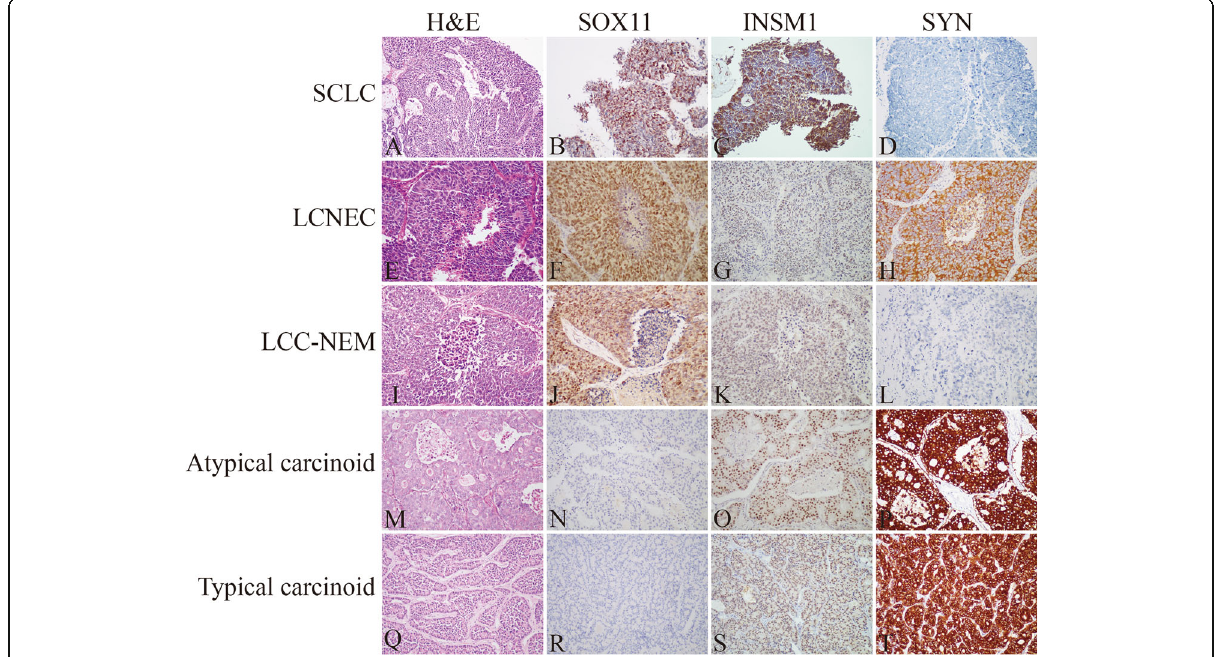
Fig. 1 Expression of SOX11, Insulinoma-associated protein 1(INSM1), and synaptophysin (SYN) in small cell lung carcinoma (SCLC), large cell neuroendocrine carcinoma (LCNEC), large cell carcinoma with neuroendocrine morphology (LCC-NEM), atypical carcinoid and typical carcinoid . A-D , SCLC. Small densely packed tumor cells exhibit a sheet-like diffuse growth pattern ( A ). Tumor cells demonstrate strong nuclear staining of SOX11 and INSM1( B, C ), negative staining of SYN ( D ) and other traditional neuroendocrine markers. E-H , LCNEC. Rosette-like structures and large zones of necrosis are observed in a LCNEC ( G ). Positive immunohistochemical staining was observed for SOX11, INSM1 and SYN ( F, G, H ). I-L , LCC-NEM. Large cell carcinoma demonstrating an organoid growth pattern ( I ). Tumor cells are positive for SOX11 and INSM1 ( J, K ), negative for SYN ( L ) and other traditional neuroendocrine markers. M- T , typical and atypical carcinoid. Organoid and rosette structure was observed in an atypical carcinoid ( M ) and typical carcinoid ( Q ). SOX11 expression is not found in the atypical carcinoid ( N ) and typical carcinoid ( R ). INSM1 and SYN reactivity are present in tumour cells of atypical carcinoid ( O, P ) and typical carcinoid ( S, T ). Magnification ( A-I ): 200x